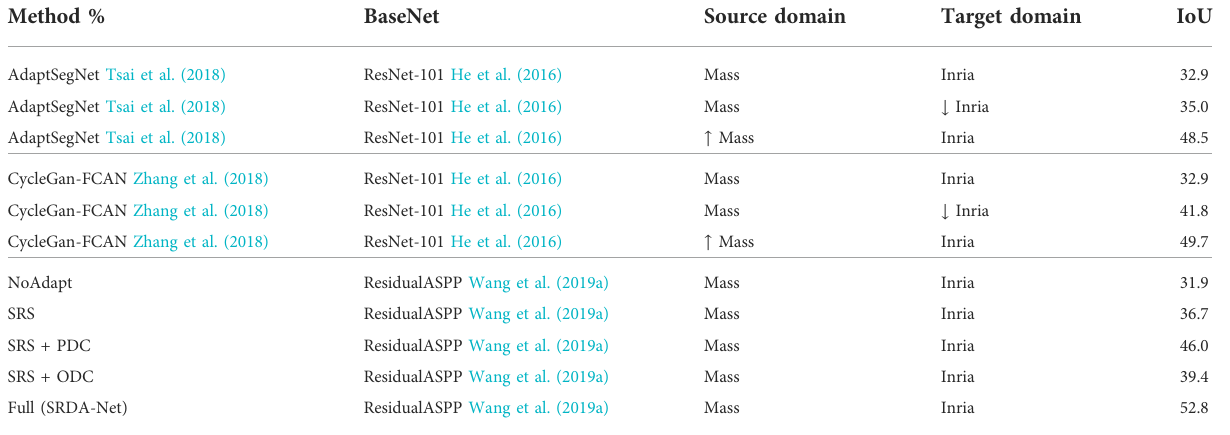
TABLE 1 Comparison results of domain adaptation from Mass to Inria val